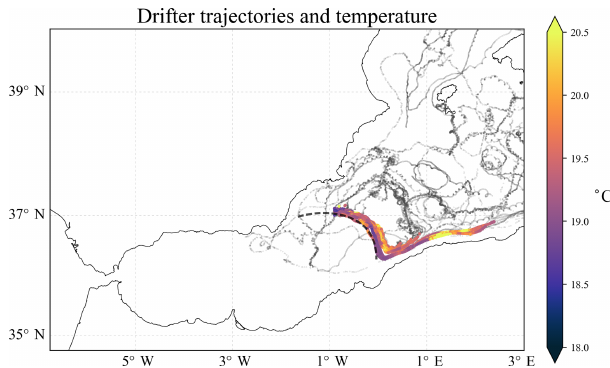
Figure 8. Surface drifter trajectories. For the sake of simplicity and clarity, the temperature, when available, is only shown for the dura- tion of the AlborEx mission (25–31 May